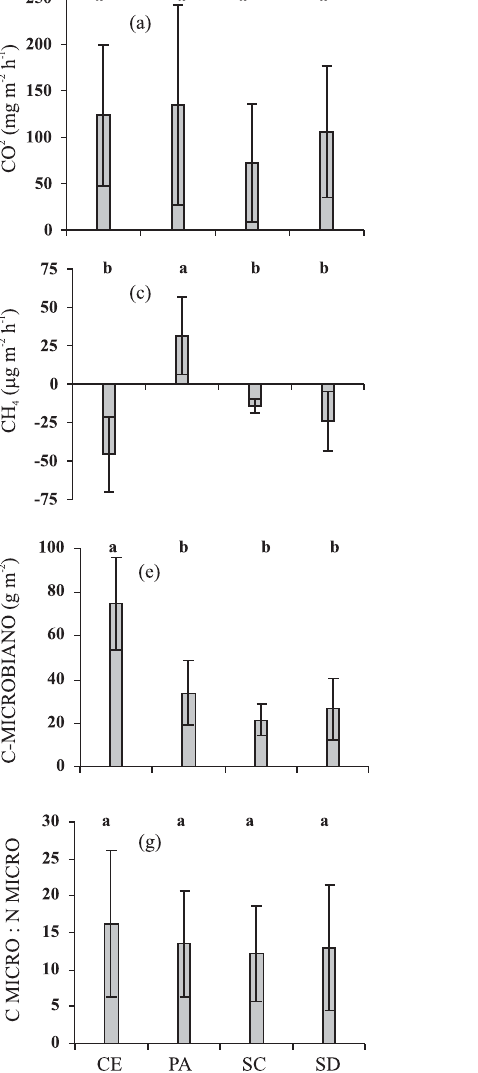
Figura 2. Média e desvio para: (a) emissão de CO (NH 4+ e NO 3- ); (e) C-microbiano; (f) N-microbiano; (g) relação Cmicro:Nmicro; e (h) umidade do solo nas áreas com diferentes usos da terra no bioma Cerrado, em uma camada superficial (0-0,10 m) de solo. Letras iguais não foram significativamente diferentes (p ≥≥≥≥≥ 0,05); ns: não